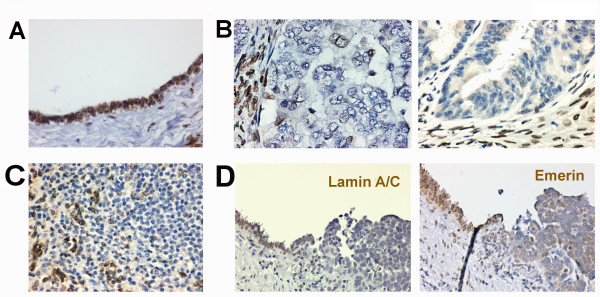
Loss of lamin A/C expression in ovarian cancers. Ovarian normal and tumor tissues were analyzed by immunostaining for lamin A/C. (A) A representative example shows that lamin A/C is strongly stained around the nucleus of normal ovarian surface epithelial cells. The nuclei are generally smooth and oval-shaped in all normal ovarian surface epithelial cells. (B) Two examples show loss of lamin A/C expression in ovarian carcinomas. Some stromal cells show strong lamin A/C staining around the nucleus, serving as an internal positive control. The nuclear morphology of tumor cells is heterogeneous, and some cells with large and deformed nuclei are present. (C) A representative example of ovarian carcinomas showing heterogeneous expression of lamin A/C among the tumor cells. (D) An example of ovarian carcinomas contiguous with the benign ovarian surface epithelium. Lamin A/C is lost in the transformed cells. In an adjacent section, the loss of lamin A/C correlates with the distribution of emerin to the cytoplasm of tumor cells.